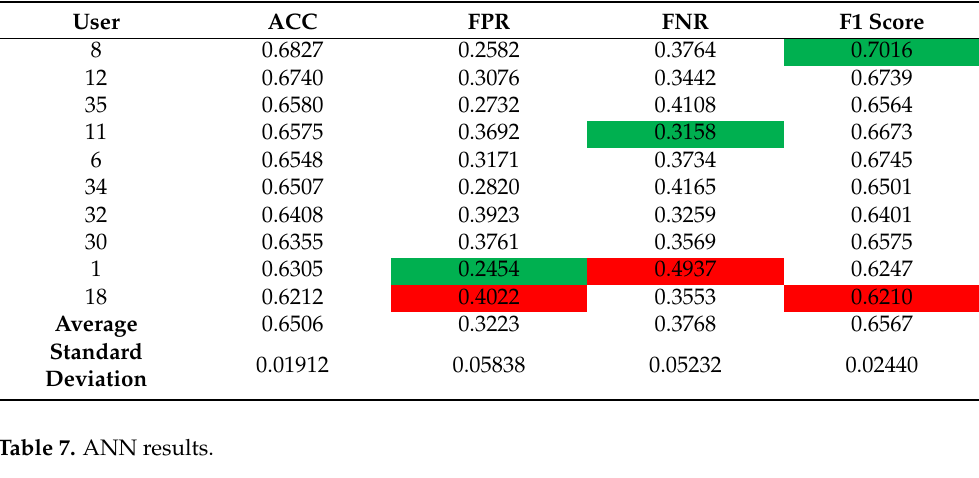
Table 6. RF results.